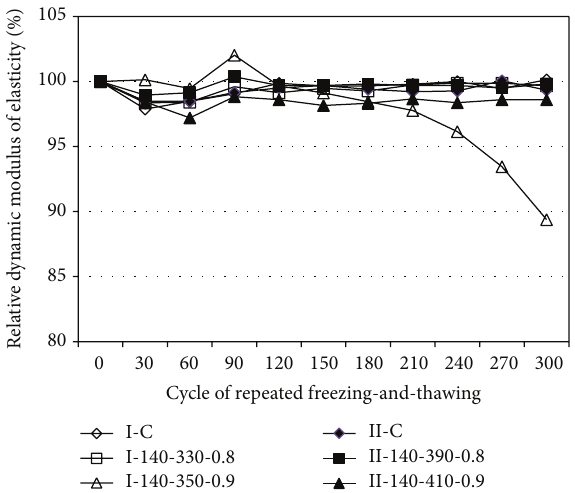
Figure 8: Freezing-and-thawing resistance of concrete tested.